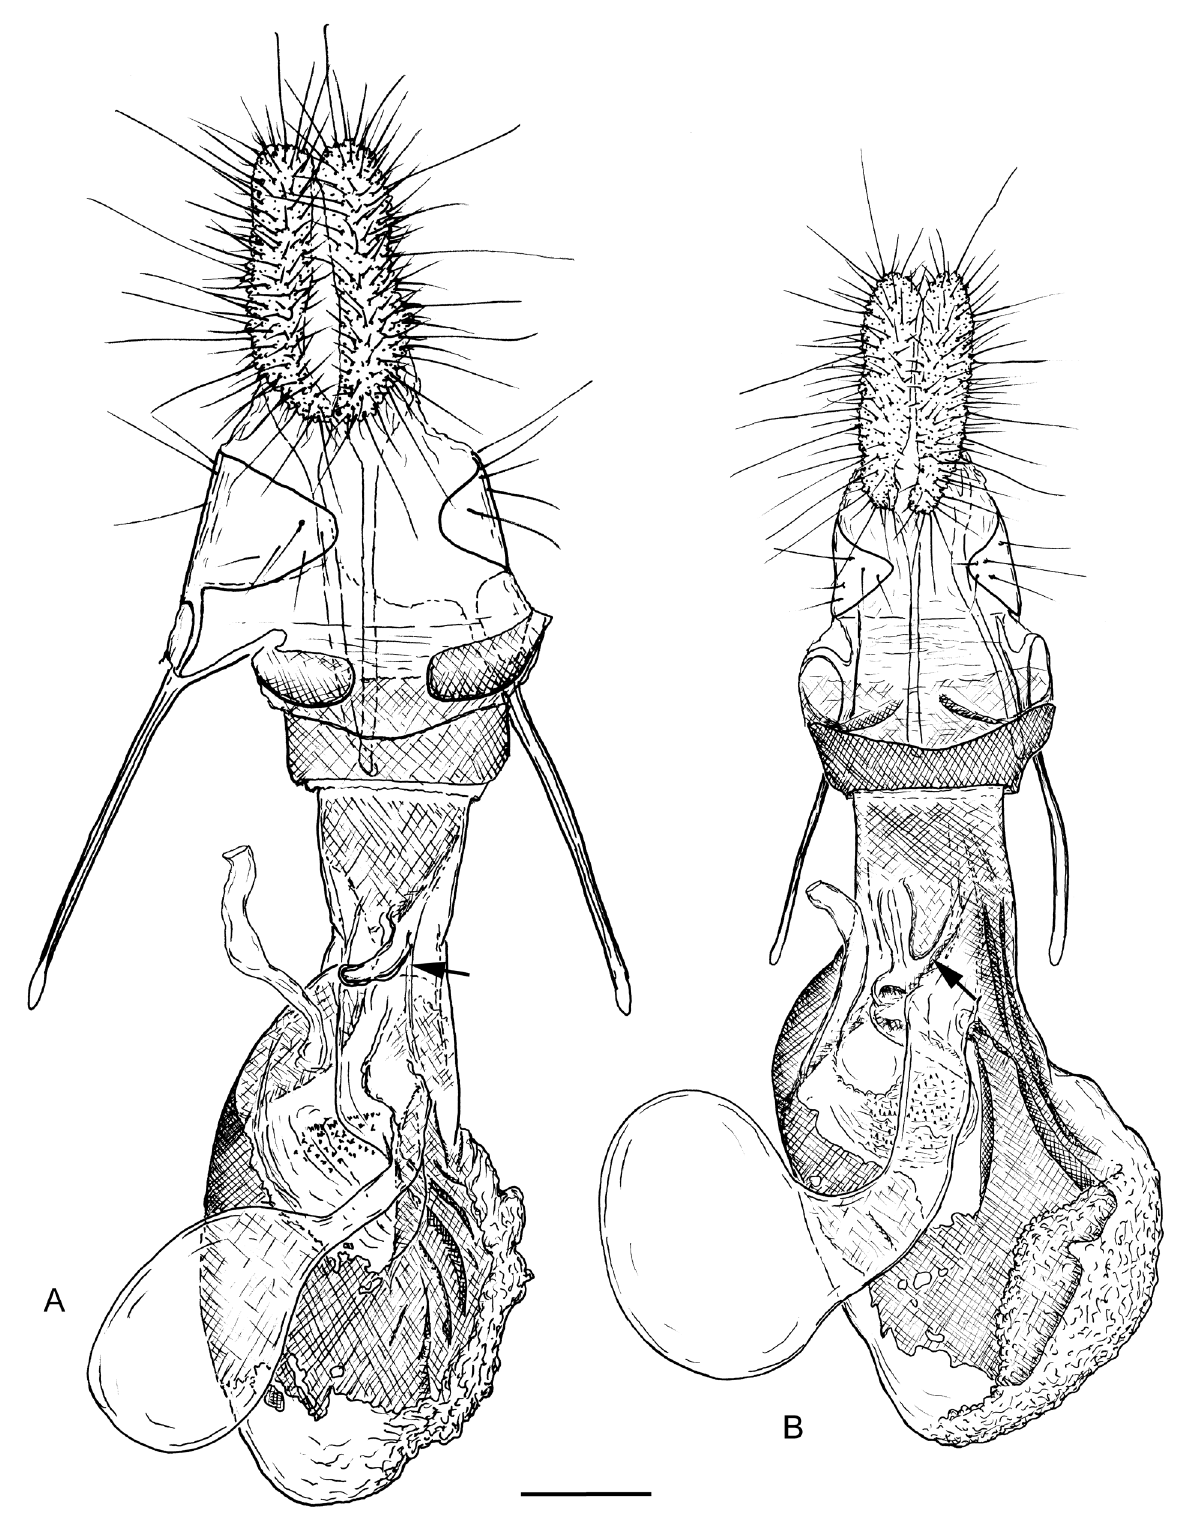
Fig. 8. Female genitalia of Phtheochroa spp. A . P. schawerdae (Rebel, 1908) comb. nov., Bulgaria, Rila Mts. – B . P. alpinana sp. nov., France, Alpes Maritimes, paratype. Arrow: ventral diverticulum of ductus bursae. Scale bar = 250